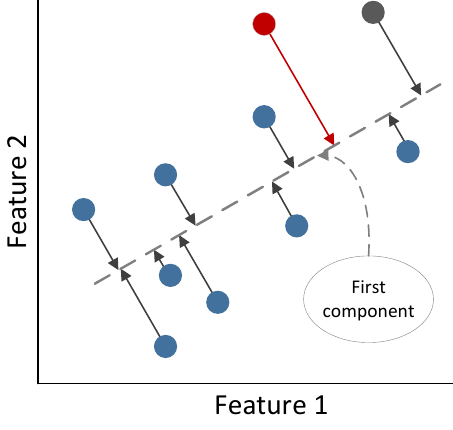
Figure 7. Representation of PCA for